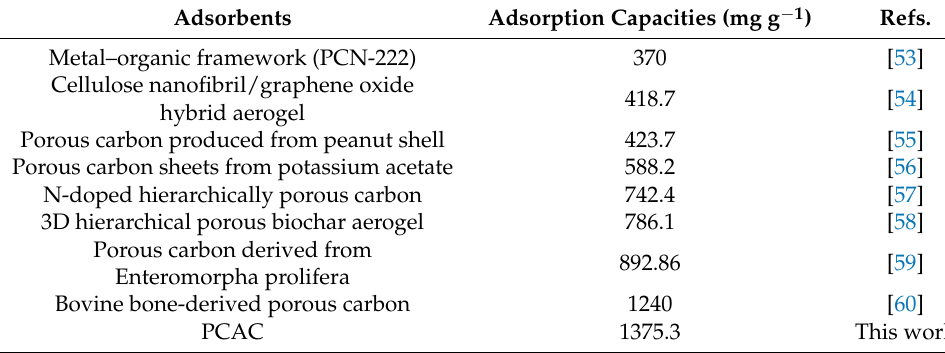
Table 3. Maximum adsorption capacities of CAP on